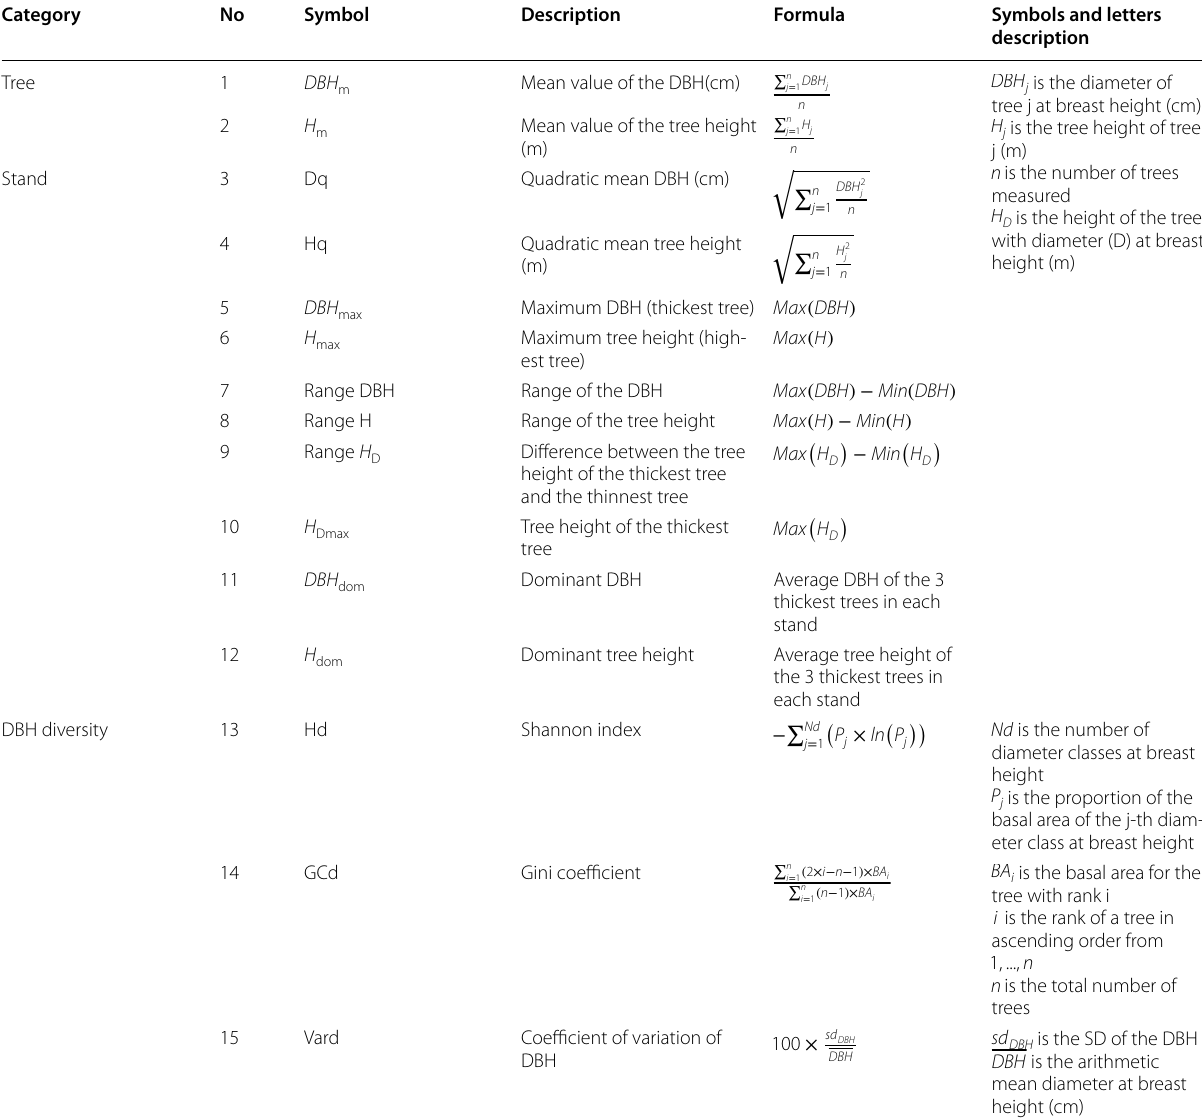
Table 17 Summary table of all stand variables involved (modified based on Ciceu et al. 2020; Dănescu et al. 2016) Category No Symbol Description Formula Symbols and letters